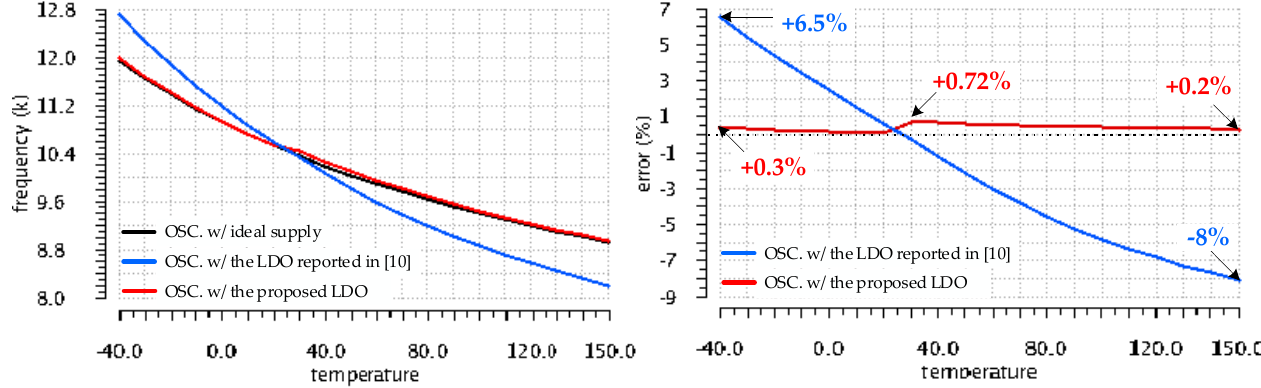
Figure 17. Variation over temperature of the frequency values yielded by the oscillator for the three supply cases shown in Figure 15 and their deviation wrt. the ideal-supply case for the Monte Carlo run that yielded the worst-case V OS temperature drift for the LDO reported in [10].